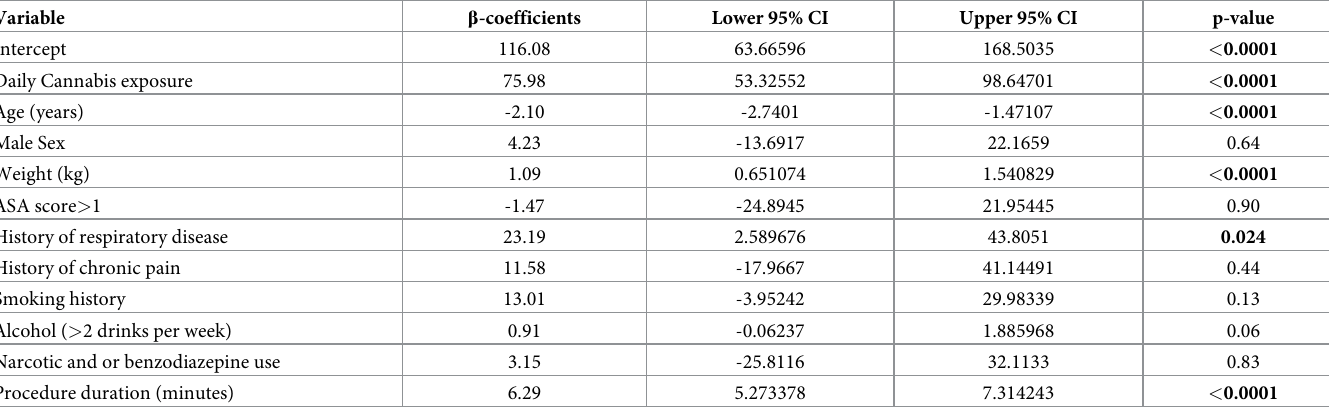
Table 2. Multiple linear regression model for the degree of association between cannabis exposure and propofol dose (n = 318, adjusted R 2 = 0.61).